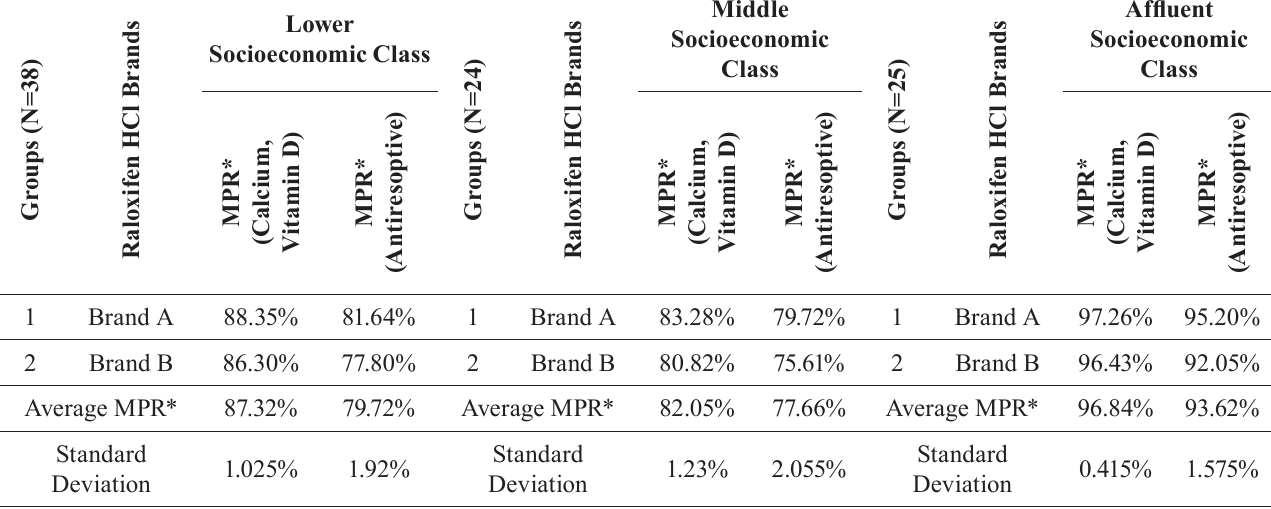
38 = N ( up s o r G